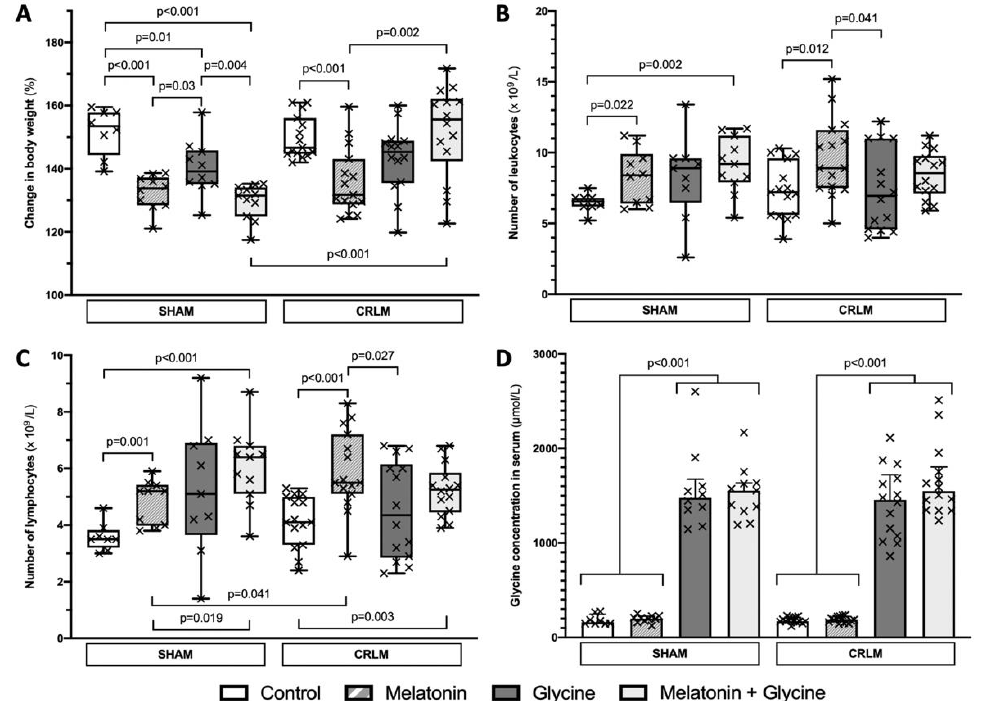
Figure 4. Change in body weight, number of leukocytes and lymphocytes, and glycine concentration in serum at the end of experiment. ( A ) Change in body weight was expressed as ratio of body weight (g) at the end and beginning of the study × 100% in study groups; ( B ) Number of leukocytes at the end of the study in study groups; ( C ) Number of lymphocytes at the end of the study in study groups; ( D ) Glycine concentration in serum at the end of the study in study groups. Data presented as median and interquartile range. Each cross mark represents individual case. CRLM; colorectal cancer liver metastasis. Table 1. Detailed data about leukocytes and lymphocytes count and glycine concentration in serum at the end of the study in study groups.